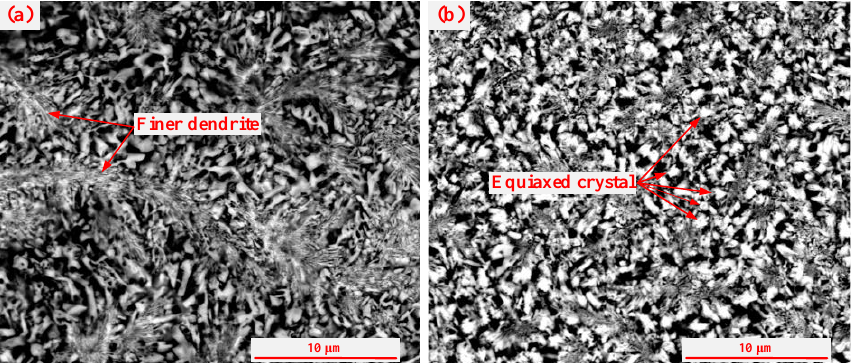
Figure 9. SEM images of the cladding layers of samples 6 and 7. ( a ) SEM image of the top of the coating of sample 6; ( b ) SEM image of the top of the coating of sample 7.